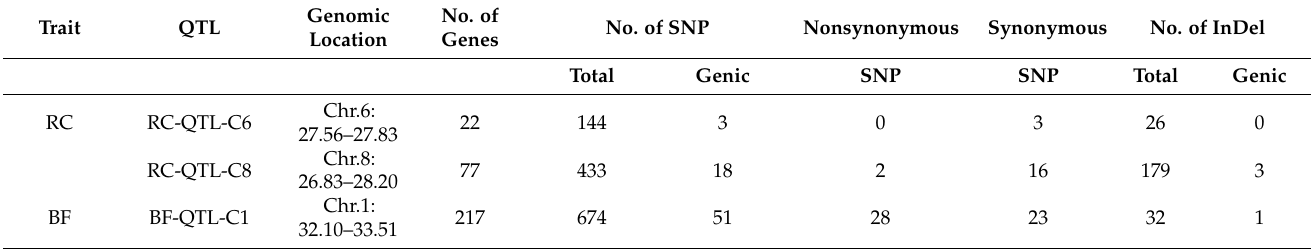
Figure 2. ( a ) Delta single nucleotide polymorphism (SNP)-index plots between dark green (DG)- and light green (LG)-bulk for rind color (RC) in chromosomes (Chr.) 6 and 8; ( b ) Delta SNP-index plots between bloom (B)- and bloomless (BL)-bulk for bloom formation (BF) in Chr.1. Each spot indicates an SNP. The green line indicates a probability value of <0.05, and the yellow line indicates a probability value of <0.01. The significant genomic regions (RC-QTL-C6 and RC-QTL-C8) are highlighted in red. Table 1. List of quantitative trait loci (QTLs) for rind color (RC) (dark green vs. light green) and bloom formation (BF) (bloom vs. bloomless) in watermelon fruit identified by QTL-seq. The number of genes, single nucleotide polymorphisms (SNPs), and insertion/deletion (InDel) in the QTL regions.